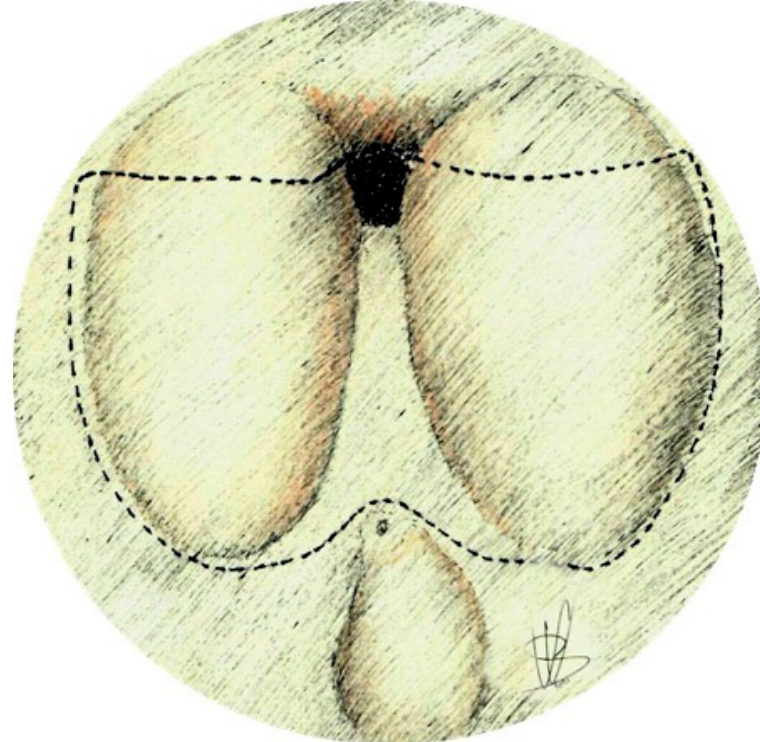
Figure 4. Graphical representation of an endoscopic adenoma incision. Appl. Sci. 2021 , 11 , 2467